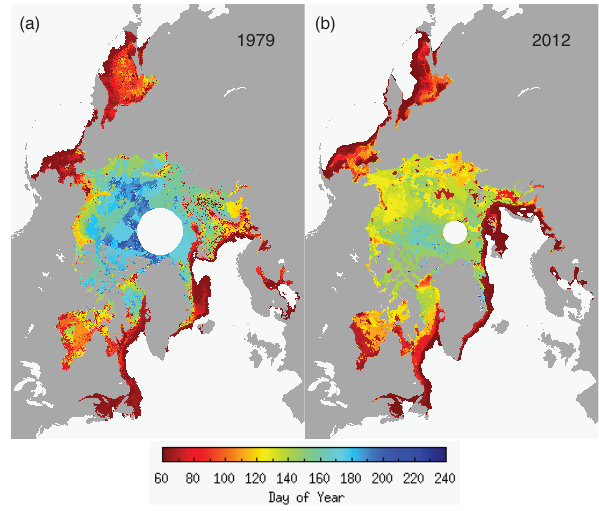
Figure 1. Annual melt onset date maps for (a) 1979 and (b) 2012 (maps available from Anderson et al., 2014).